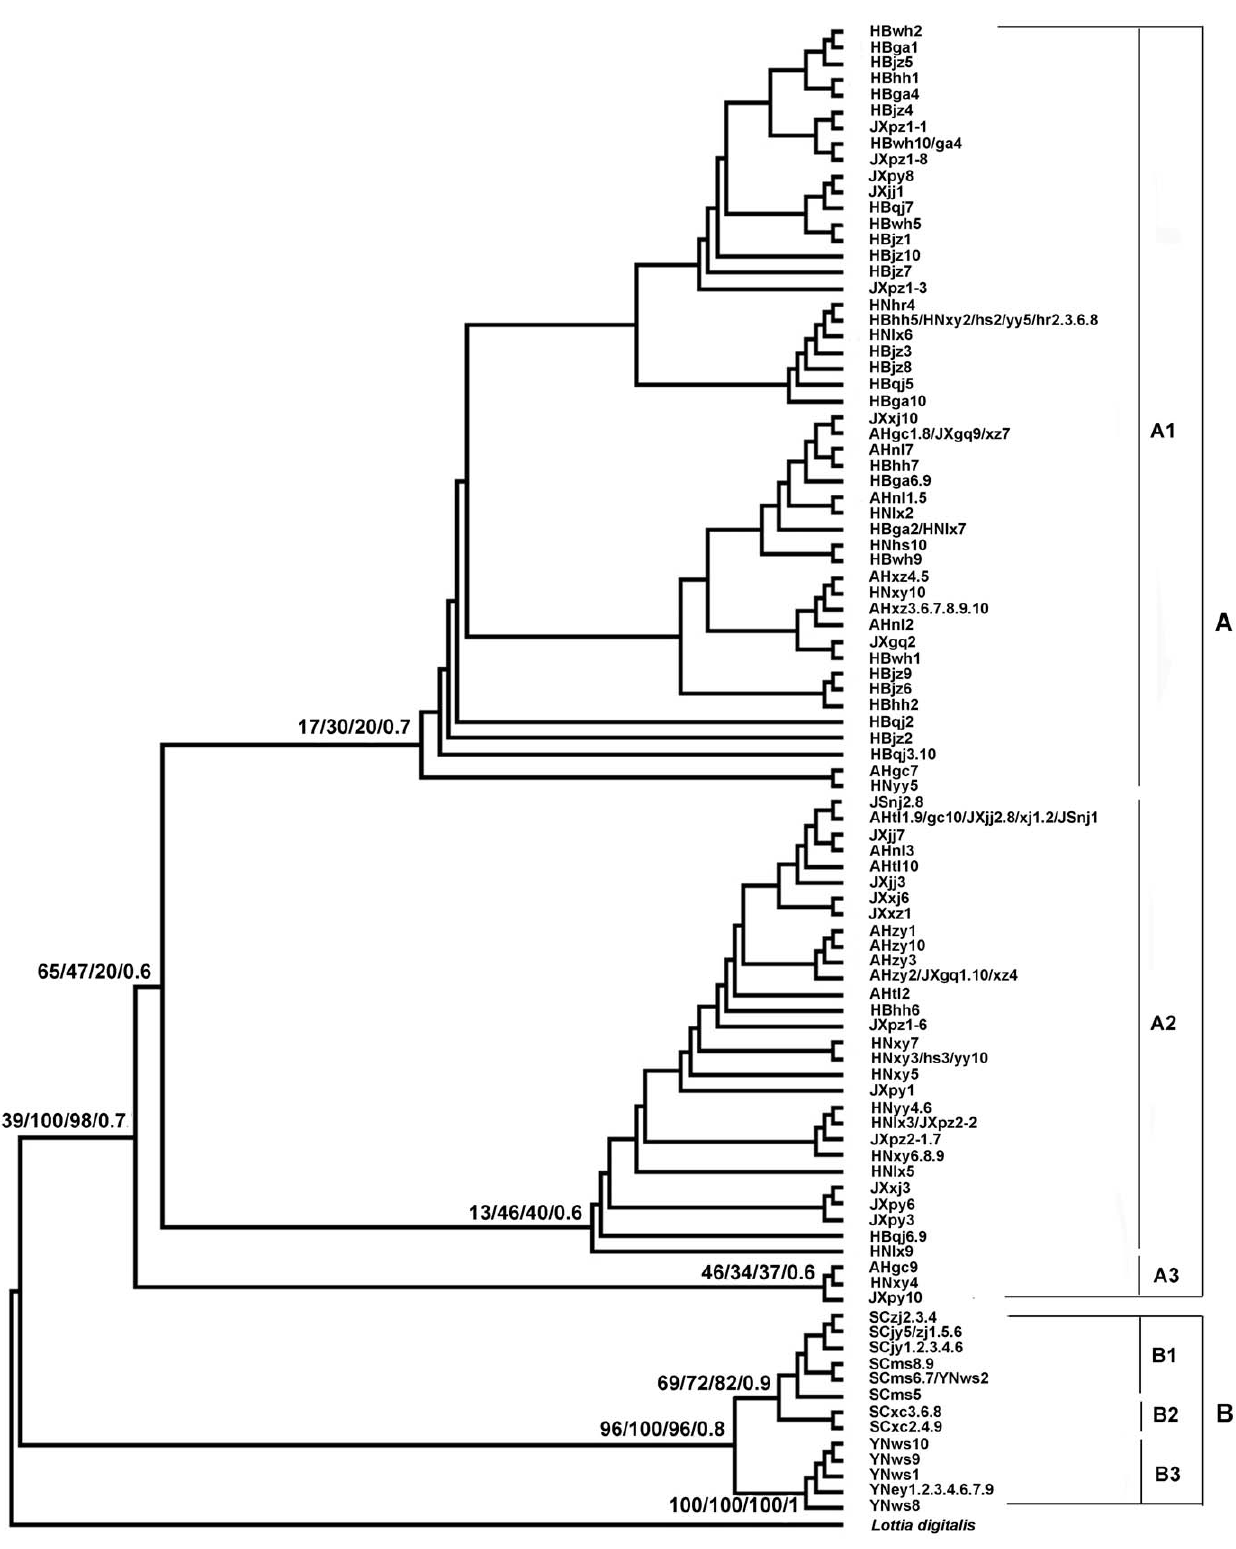
Figure 3. Phylogram of Oncomelaniahupensis based on ITS1–ITS2 sequences. Values beside the branch represent proportions of 1000 bootstrap pesudoreplicates and posterior probabilities in which the node was recovered for ML/NJ/MP/BI, respectively. The letters after each branch represent different sampled individuals coded by locality letter followed by sample isolate number, and samples in one branch shared one haplotype.